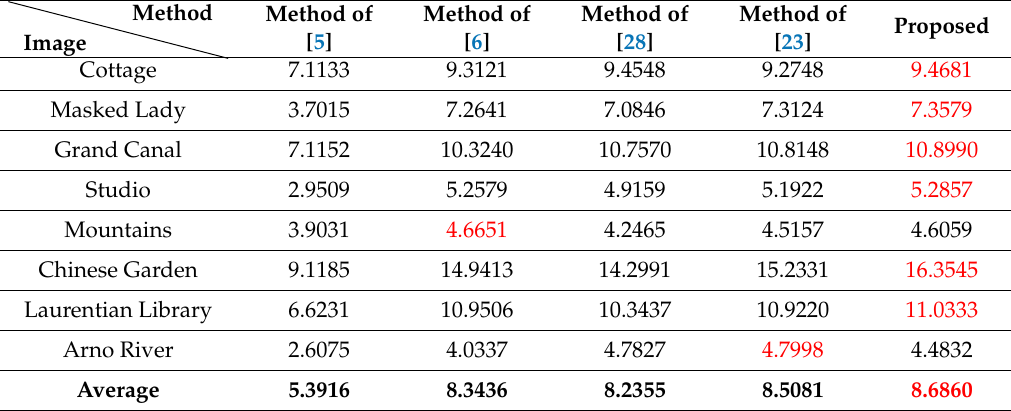
Table 2. Comparison of the five methods in terms of image CSMI